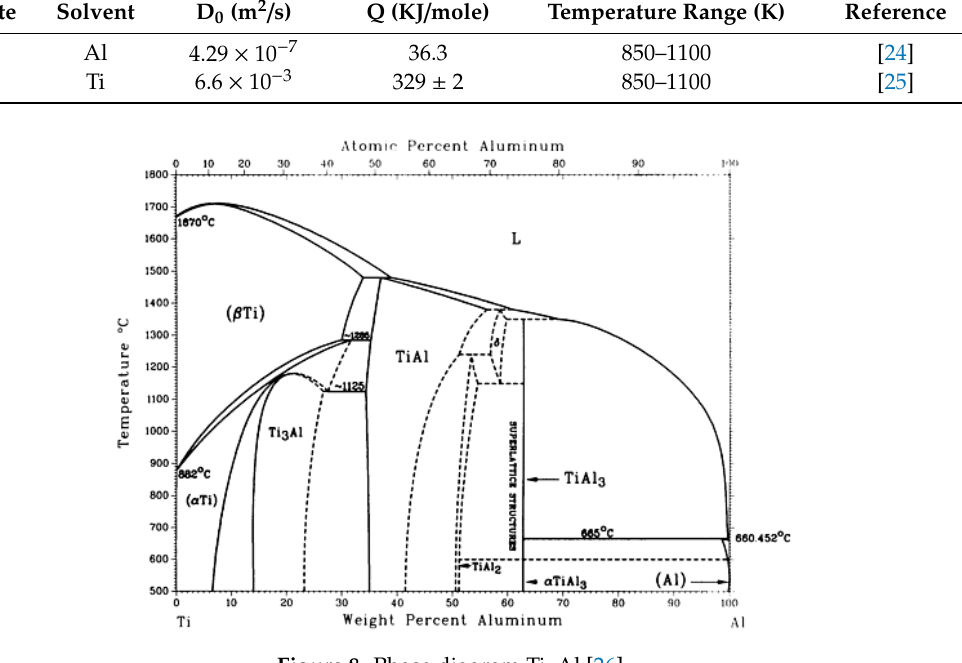
Figure 8. Phase diagram Ti–Al [26].